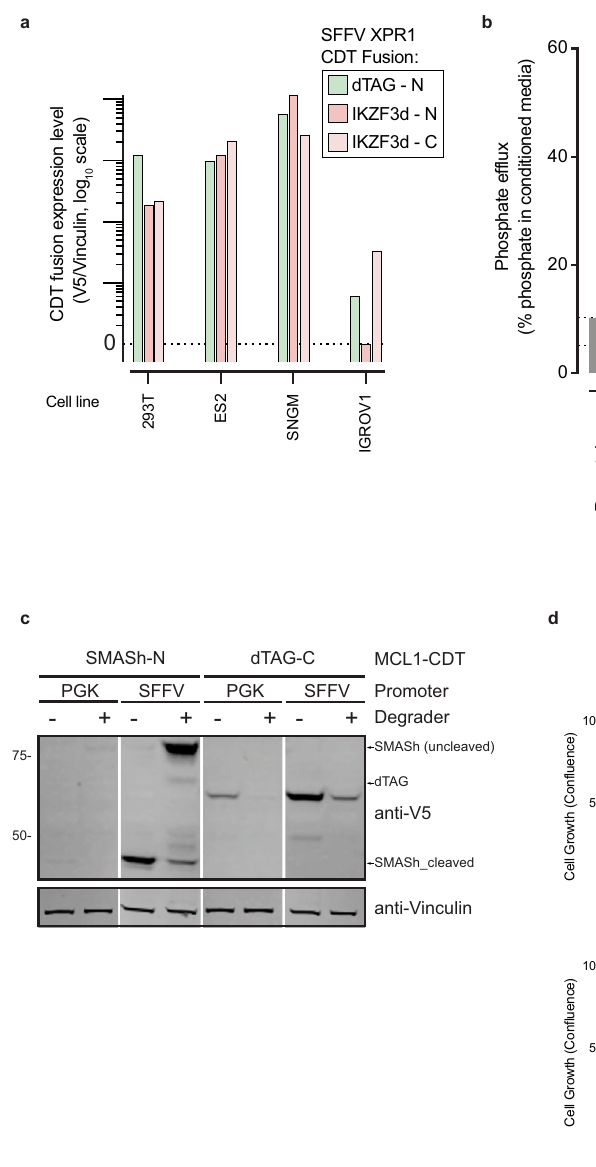
the mean of technical triplicates (shown as points), and the results are repre- sentative of twoindependent experiments. c MCL1-CDTfusions are expressed and degraded in A375 cells. Cells expressing the indicated MCL1-CDT proteins were treatedwith1 μ MAsunapreviror1 μ MdTAG V −